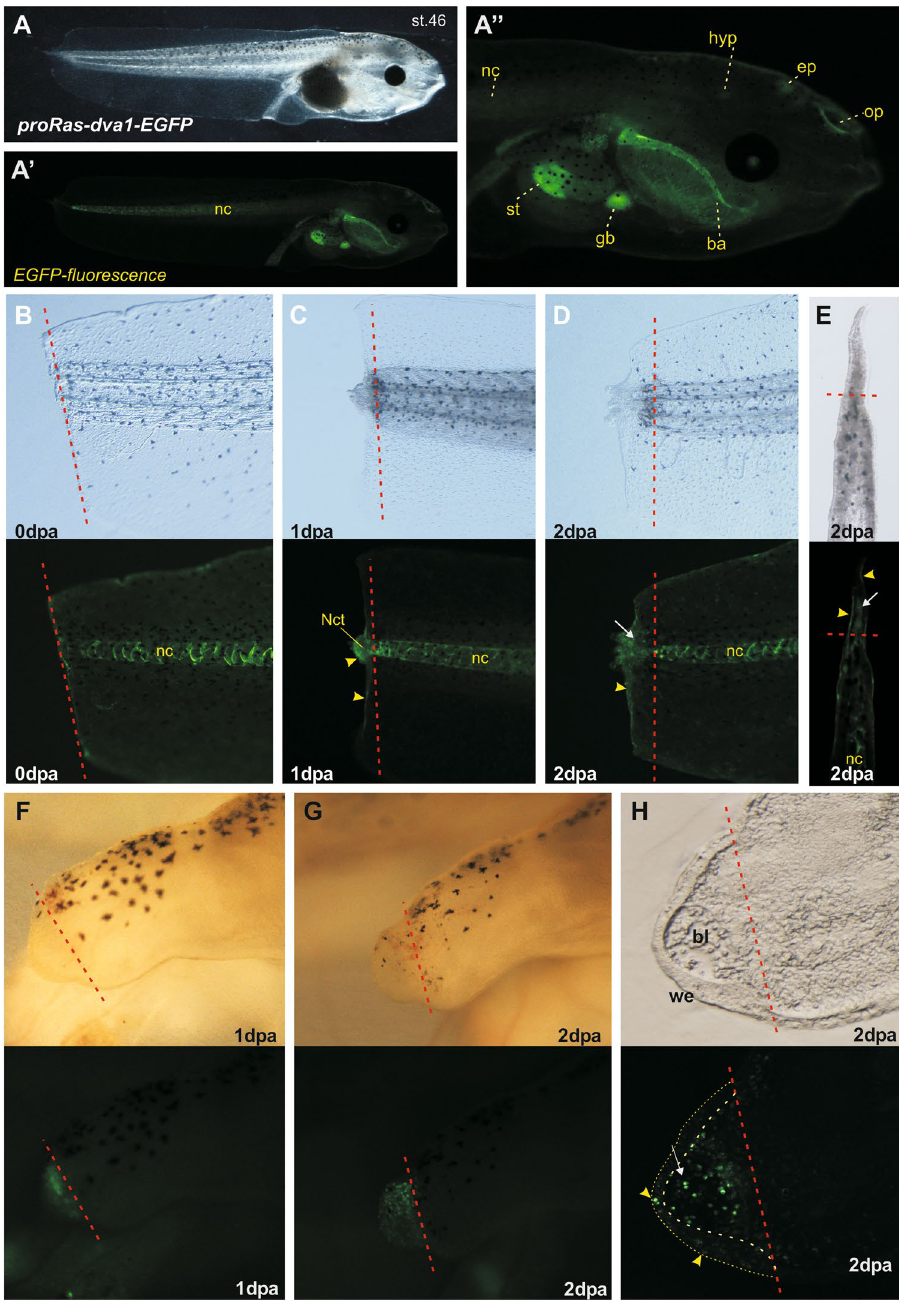
Figure 4. Promoter activation analysis in transgenic tadpoles, expressing EGFP under the xRas-dva1 promoter control. ( A ,A’,A”) The transmitted light ( A ) and fluorescent (A’) images of whole transgene tadpole on stage 46 at 3 dpa, showing strong activity of xRas-dva1 promoter in the notochord, gut and the head. The enlarged fluorescent image of head region (A”) demonstrates the EGFP fluorescence in ba - branchial arches, ep- epiphysis, gb - gall-bladder, hyp – hypophysis, nc – notochord, op - olfactory pits, st – stomach. ( B – E ) The transmitted light and fluorescent images of proRas-dva1-EGFP tadpole’s st.42 tail tip just after amputation 0 dpa ( B ), at 1 dpa ( C ), at 2 dpa ( D ) and its sagittal section ( E ). ( F – H ) The transmitted light and fluorescent images of proRas-dva1-EGFP tadpole st.52 hindlimb bud at 1 dpa ( F ), at 2 dpa ( G ) and its sagittal cryosection ( H ). Red dashed line indicates the amputation level. The yellow arrowheads point on cells of wound epithelium. The white arrows point on blastema cells. The yellow dashed lines on H indicate wound epithelium